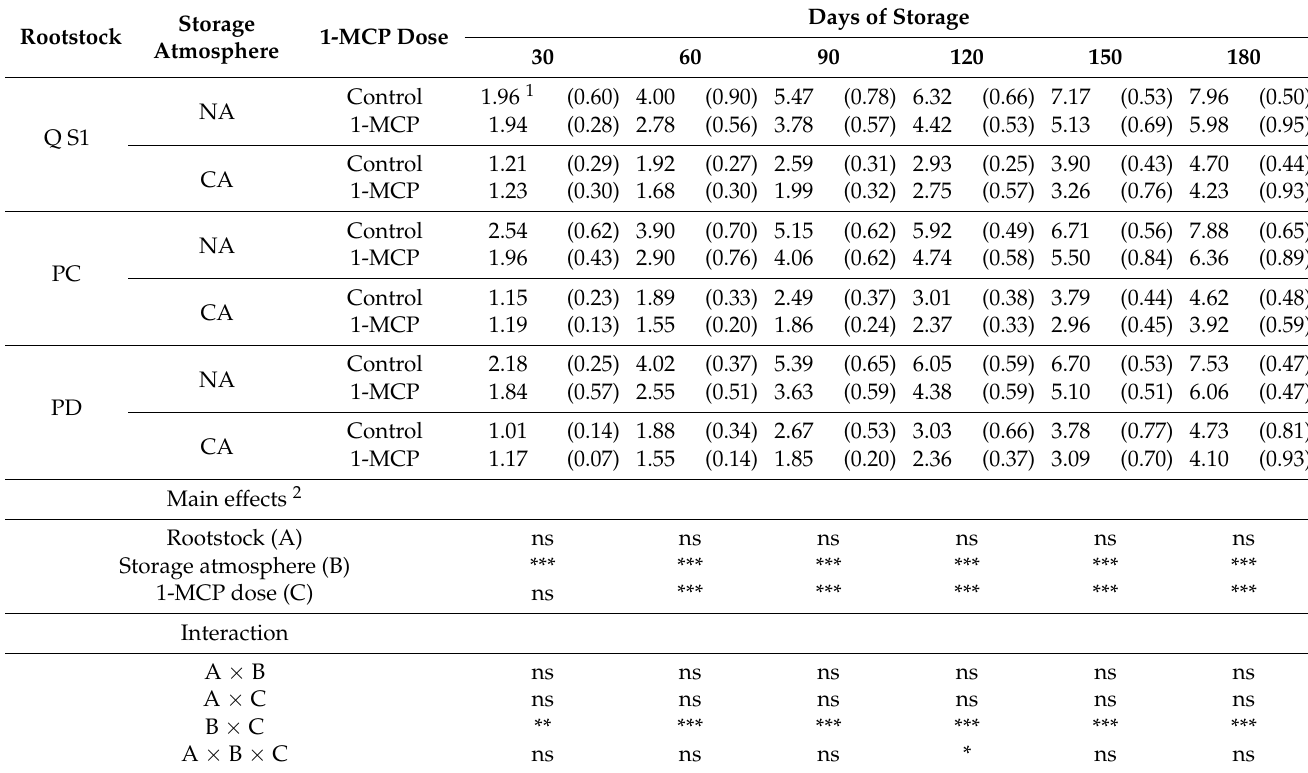
Table 3. Mass loss of non-1-MCP-treated (control) and of 1-MCP-treated ‘Conference’ pears after storage in normal (NA) and controlled (CA) atmosphere in 2012.